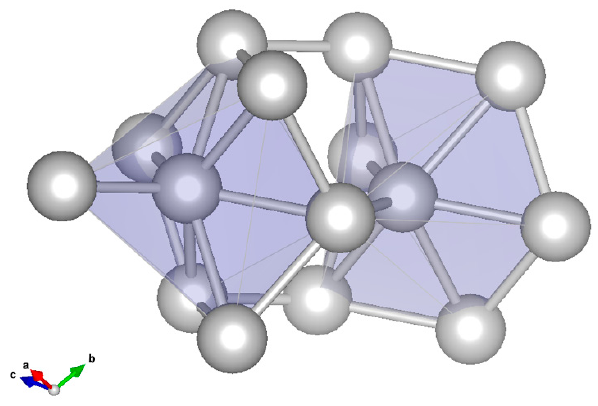
Figure 1. Gallium crystal.